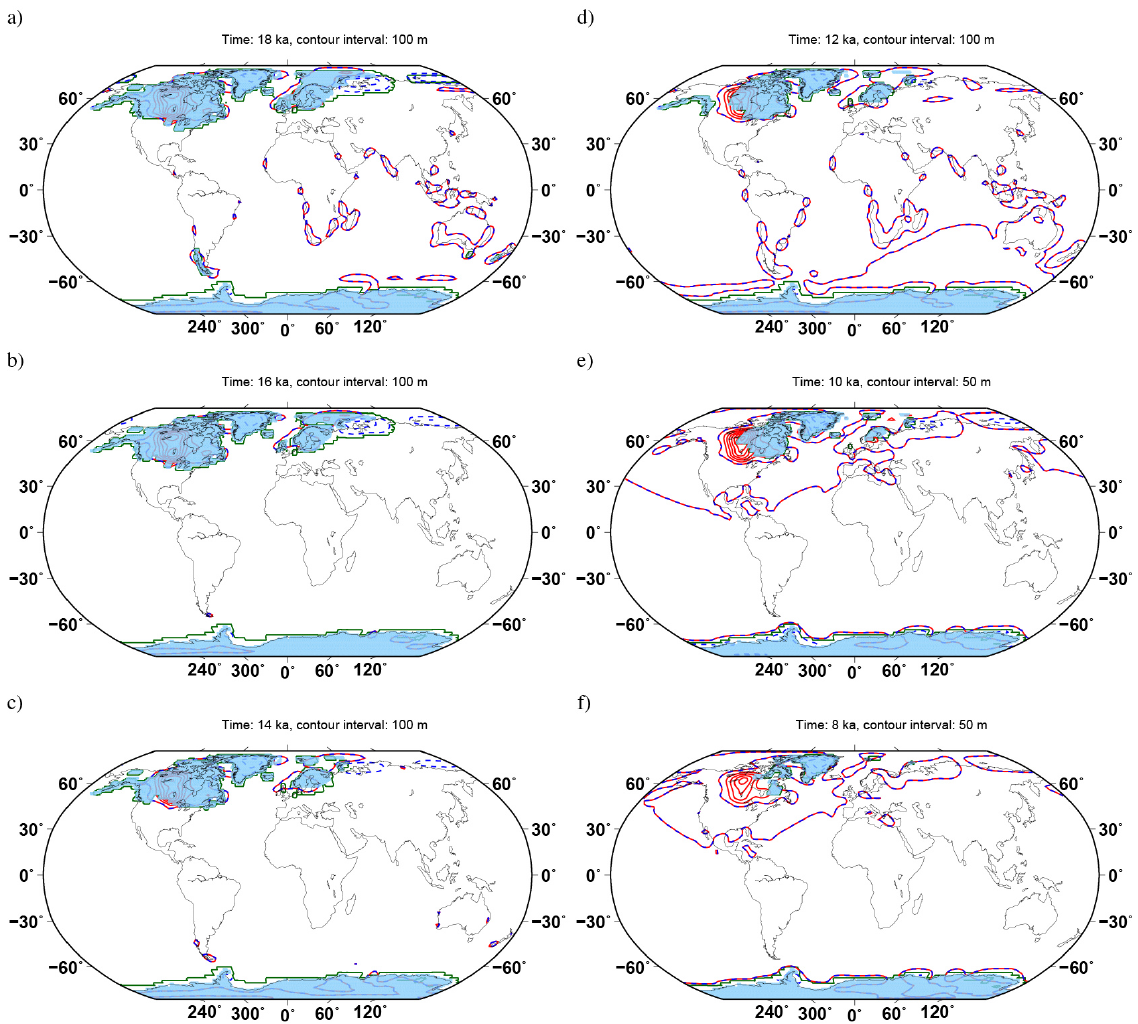
Figure 3. Sensitivity of relative sea-level data around the world to changes in ice model at (a) 18, (b) 16, (c) 14, (d) 12, (e) 10 and (c) 8ka. Light blue areas mark the extent of ice sheets at the time, taken from the ICE-5G model (Peltier, 2004). Green solid line marks the ice extent from the ICE-4G model (Peltier, 1994). Red and blue-dashed lines are contours with positive and negative sensitivity, respectively. The red-blue-dashed line marks zero sensitivity. Contour intervals indicated on top. Unit in m. To read the sensitivity of a certain line, count the number of lines from the zero-sensitivity line and multiply by the contour